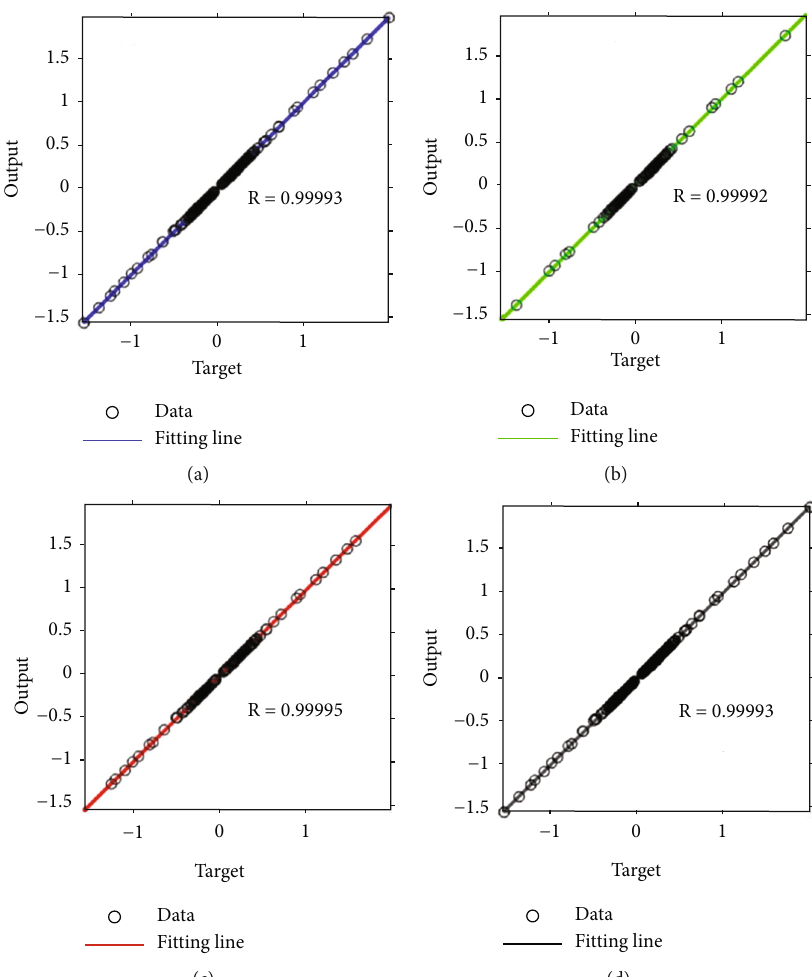
Figure 17: Correlation coe ffi cient R value of BPNN: (a) training set, (b) validation set, (c) test set, and (d) overall